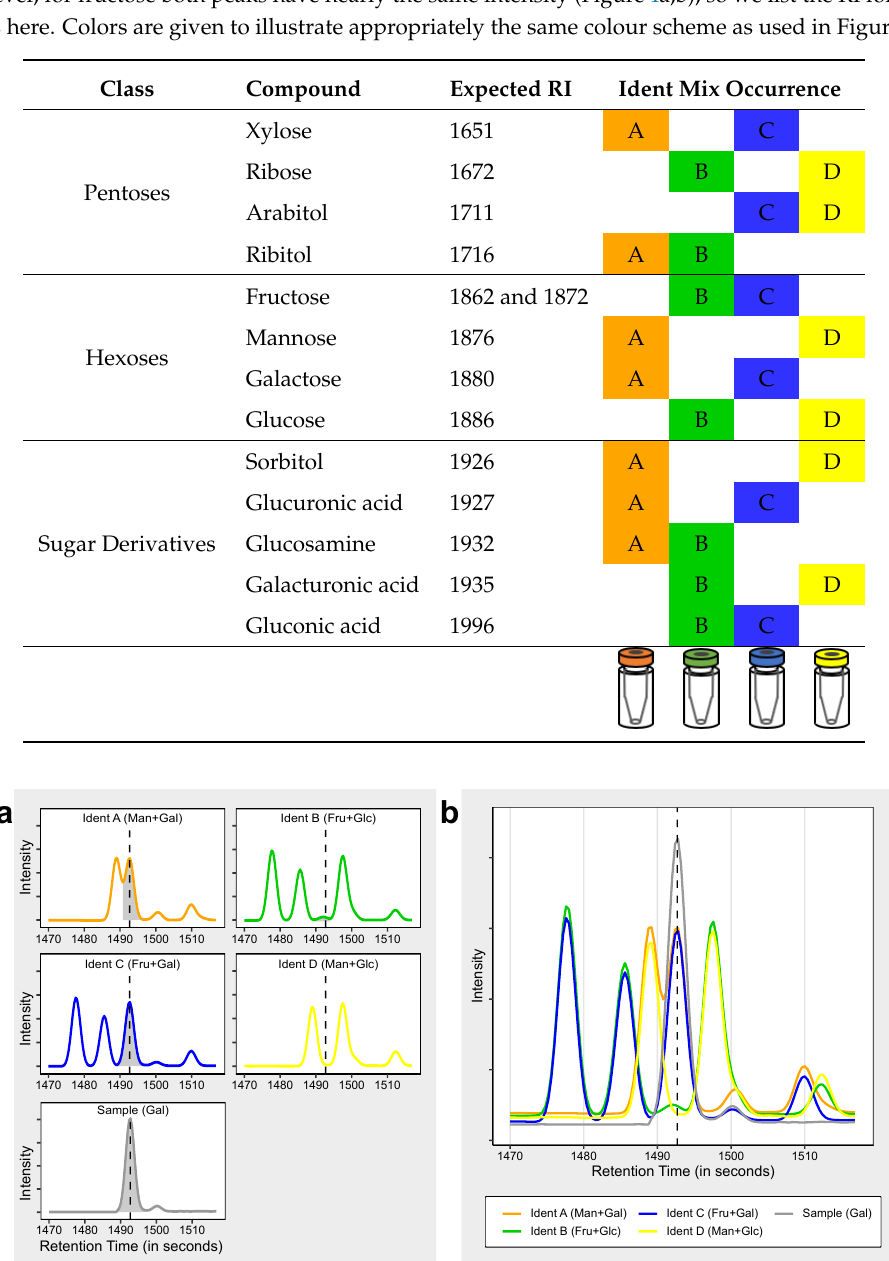
Figure 4. Application of the Ident-Mix for compound identification. ( a , b ) Illustration of retention validation using Ident-Mixes. four hexoses (fructose, glucose, galactose, mannose) with similar retention present in four different mixtures (IdentA to IdentD) and compared to a sample containing galactose. ( a ) shown with separate window for each compound as seen e.g., with Thermo Fisher Tracefinder software ( b ) Shown in overlay mode as seen e.g., with LECO ChromaTOF